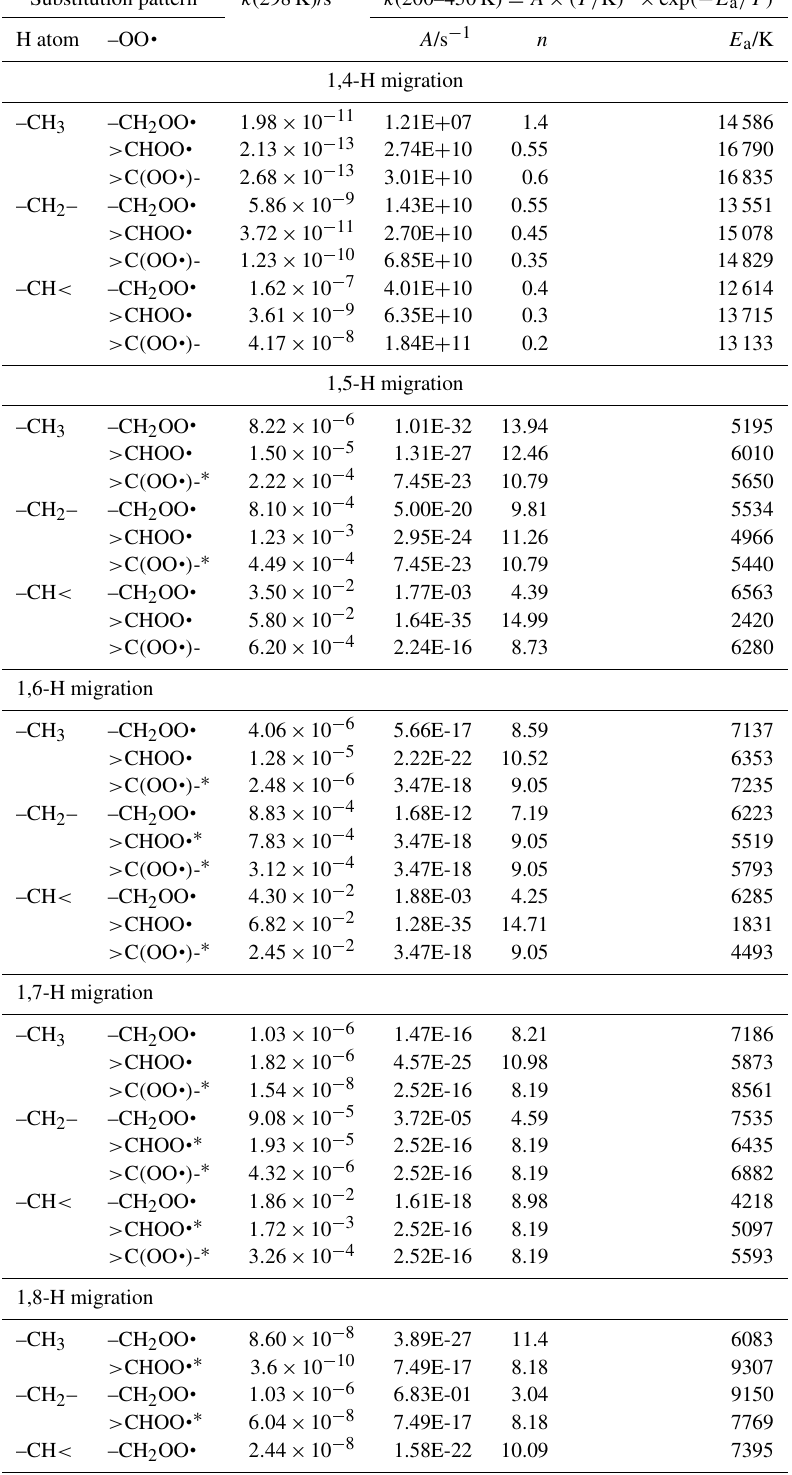
Table 1. Rate coefficients for H migration in aliphatic peroxy radicals, accounting for all abstractable H atoms in the group. Substitution